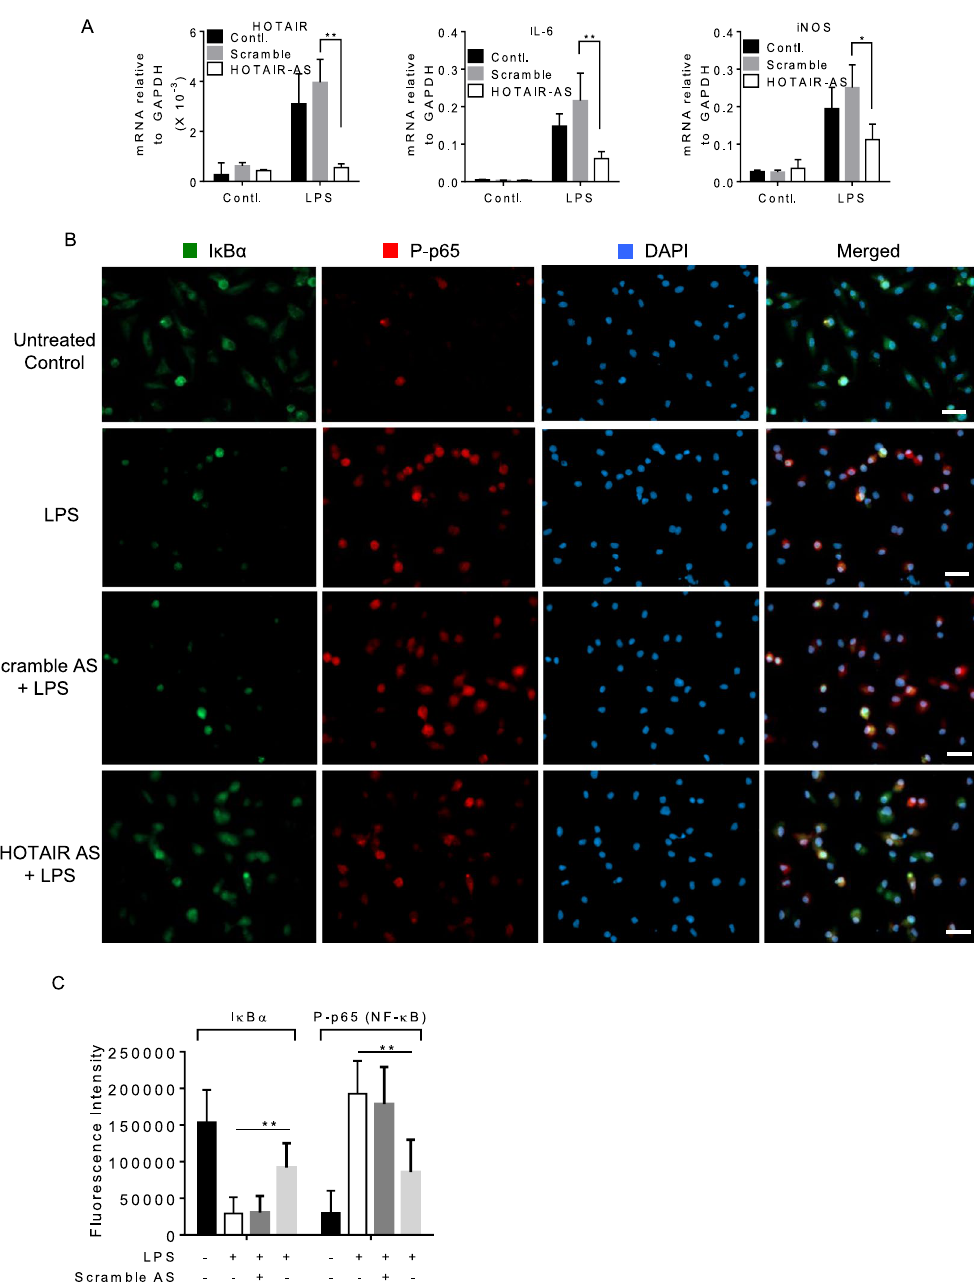
Figure 7. HOTAIR expression is induced by LPS in primary macrophages (Bone marrow derived macrophages, BMDM). ( A ) BMDM cells were treated by HOTAIR-AS and scramble-AS followed by LPS treatment and RNA was extracted. The expression of HOTAIR, IL-6, and iNOS was measured by real time PCR. ( B , C ) BMDM cells were treated by HOTAIR-AS and scramble-AS, treated with LPS and were immunostained with antibodies against I κ B α and phospho NF- κ B (P-p65), and counterstained with DAPI to visualize the nucleus. Images were taken by fluorescence microscope (Nikon ECLIPSE TE2000-U) ( B ) and fluorescence intensity showing the expressions of I κ B α and phospho NF- κ B (P-p65) was quantified by ImageJ software and plotted in panel C. Each experiment was repeated at least thrice (n = 3). Data represent mean ± SD; * p < 0.05, ** p <